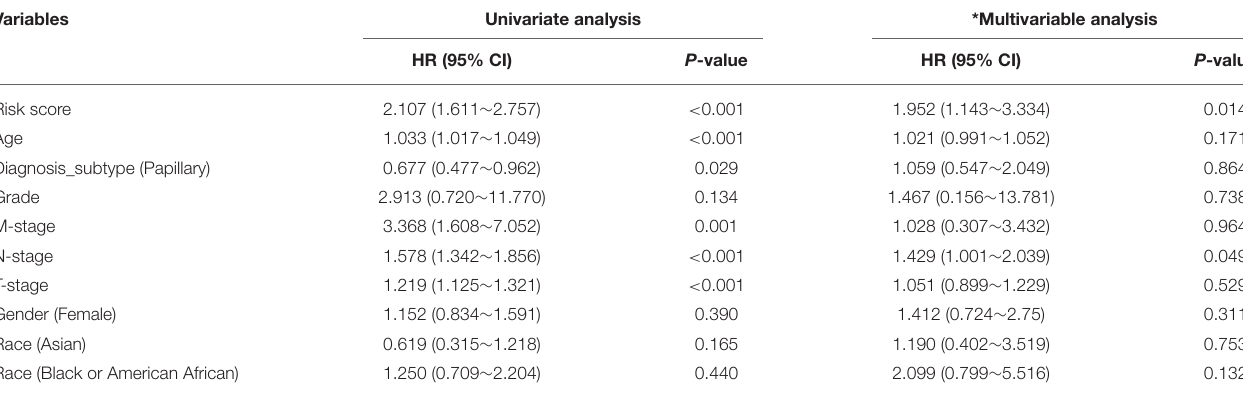
TABLE 3 | Univariate and multivariable Cox proportional regression analysis of bladder cancer patients. Variables